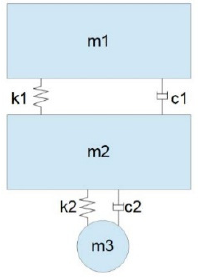
Figure 2. The 1/4 vehicle model.